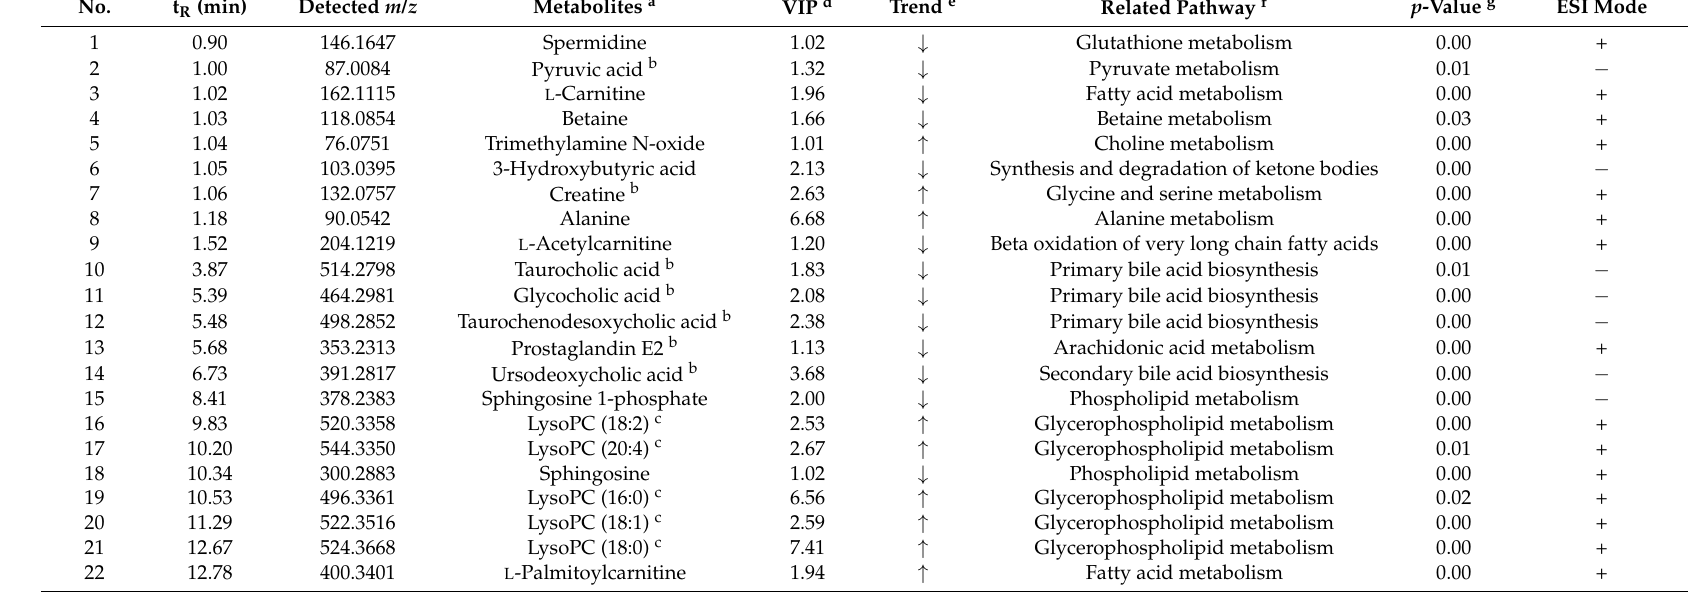
Table 1. Identification results of serum differential metabolites in control group and Sophora flavescens -induced